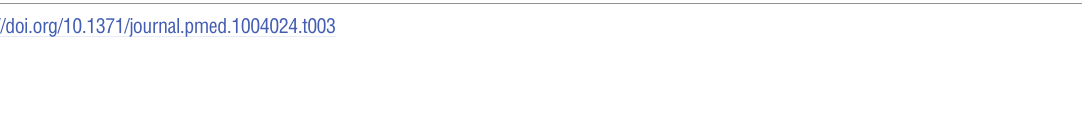
Table 3 AU : TheeventsinTable 3 aresometimesreferredtoasAEsandsometimesasSAEs : BasedontheMethodsandthetitleofTable 3 ; IeditedtoSAEsforallreferencestoTable 3 : Ifthisisnotcorrect ; pleaseeditasnecessary : summarises the disproportionality analysis that compares the occurred versus expected incidence ratio for SAEs of concern. Out of the SAEs examined, TTS seemed to occur at a rate greater than the baseline comparison, although the 95% confidence interval was